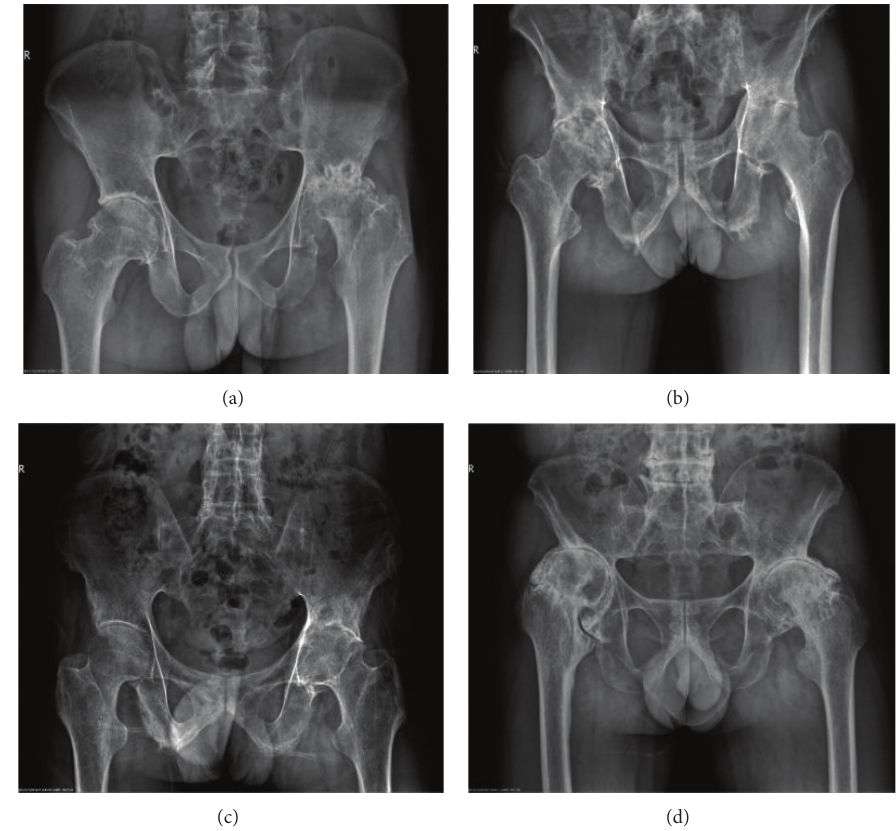
Figure 1: Radiographic findings in AS patients with advanced hip joint disease. (a) Case 3; (b) case 5; (c) case 6; and (d) case 7.